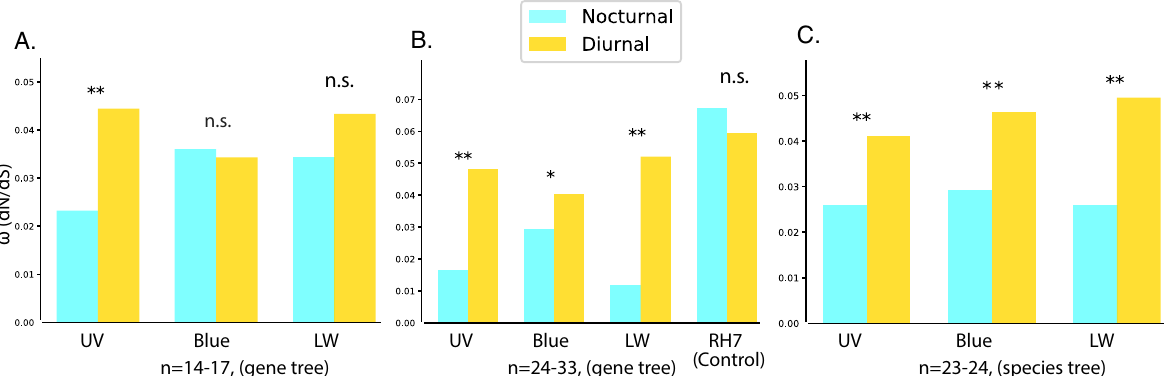
Fig. 2 Opsin selection (dN/dS) rates between nocturnal and diurnal Lepidoptera species. Different models show that rates for visual opsins are higher in diurnal taxa. A Blue, LW ( n = 17 taxa) and UV ( n = 14 taxa) opsin dataset were run using opsin gene trees. B Expanded dataset ( n = 24 taxa) for UV, Blue, and LW opsins run using gene trees. RH7 was analyzed using more species ( n = 33 taxa). C Expanded dataset run using a robust species trees (UV, LW n = 24 taxa, Blue = 23 taxa). * p -value < 0.05, ** p -value < 0.01. The signi fi cance values indicate how well different models fi t the data using likelihood ratio test (LRT). Model parameters used to run PAML and estimate the rates represented in the fi gures can be found at ref. 38 . Opsin selection rates modeled for various datasets with different sample sizes and different model parameters all show that RH4/UV, RH5/Blue, and RH6/LW visual opsins have higher dN/dS rates in diurnal species than nocturnal species. RH7, a non-visual opsin, shows no signi fi cant difference. Smaller sample sizes ( A ) often fail to detect differences, which were more apparent when using larger data sets ( B ). Using a robust species tree rather than the gene tree shows more consistent differences across the visual opsins ( C ).